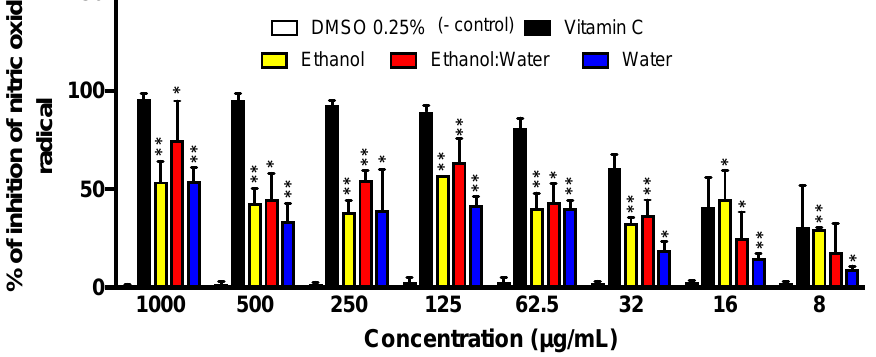
Figure 5. Nitric Oxide (NO) inhibition of 3 LT plant extracts at different concentrations (1000 µg/mL–8 µg/mL) after 4 h of incubation. The absorbance was recorded at 564 nm. Each bar represents the average of three replicates and the error bars represent the standard deviation. The asterisks indicate a significant difference between the treatment and negative control (* p < 0.05 and ** p < 0.001).